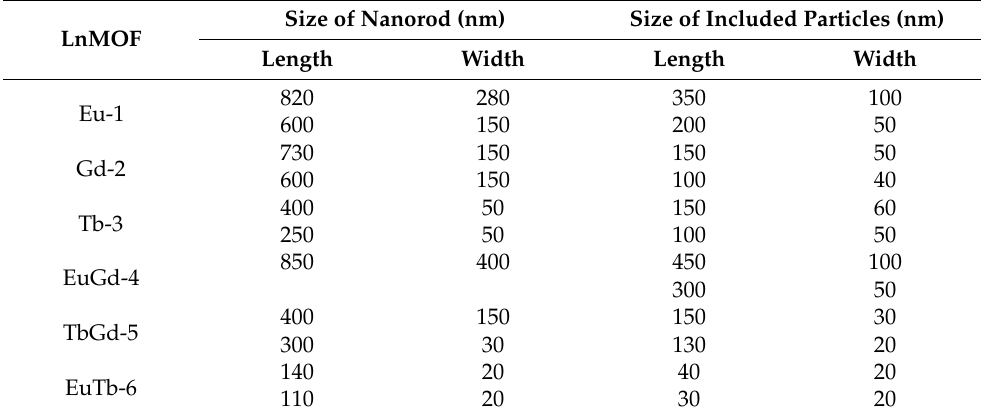
carbon gained with the STEM are rather higher (carbonized